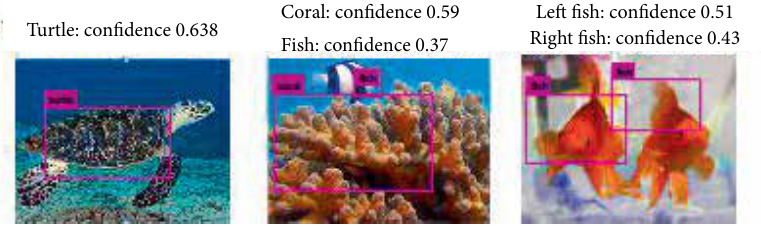
Figure 10: Object classification results from ImageNET data set.